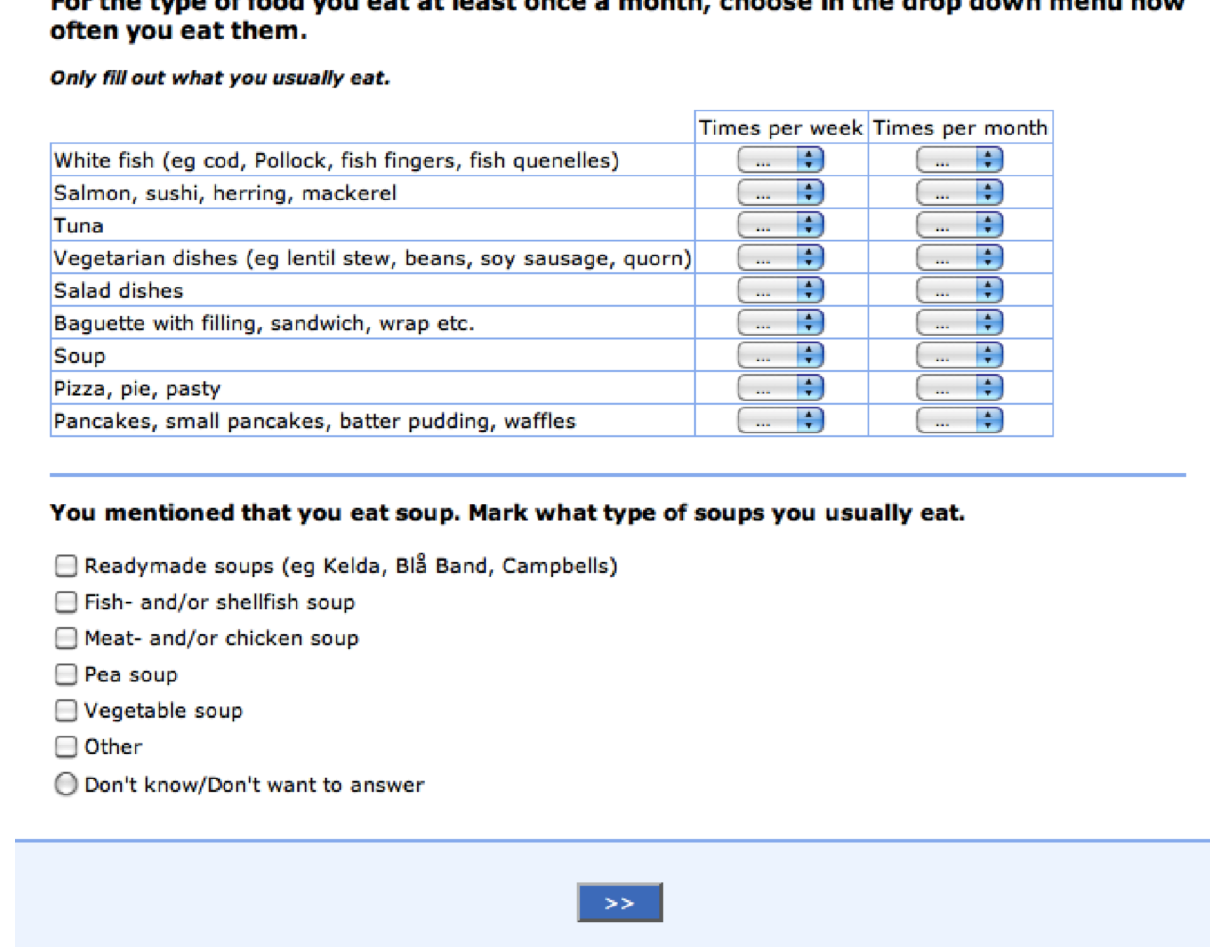
Figure 2. Screenshot of a Meal-Q module: lunch and dinner dishes and a follow-up question on soup. Translated from the Swedish questionnaire version in the VALidation of Methods Assessing diet and physical activity (VALMA)